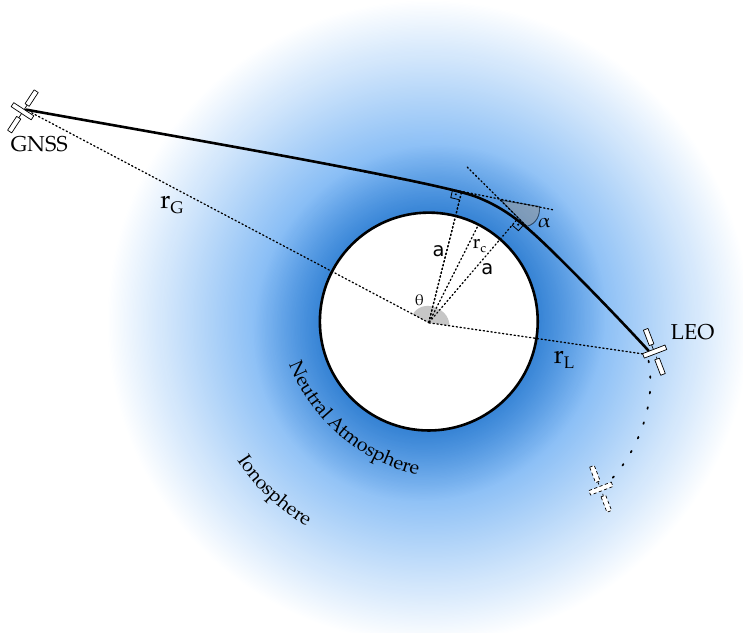
Figure 1. Overview of the geometry of an RO